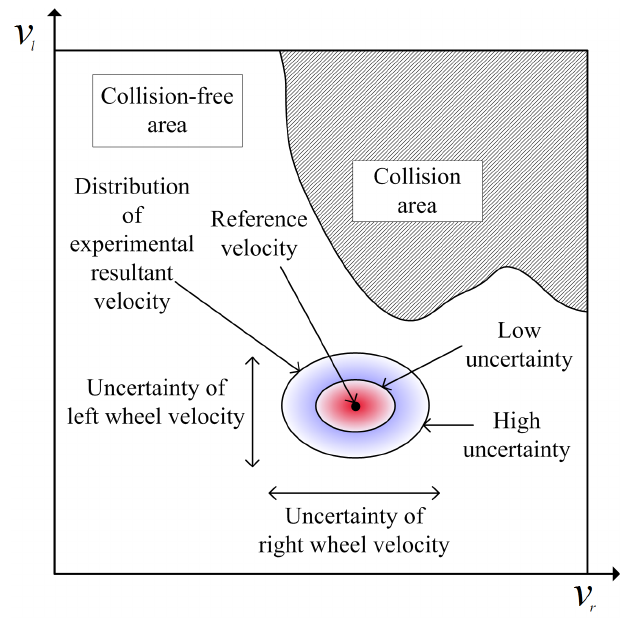
Figure 2. Uncertainty ellipse around the reference velocity in the input